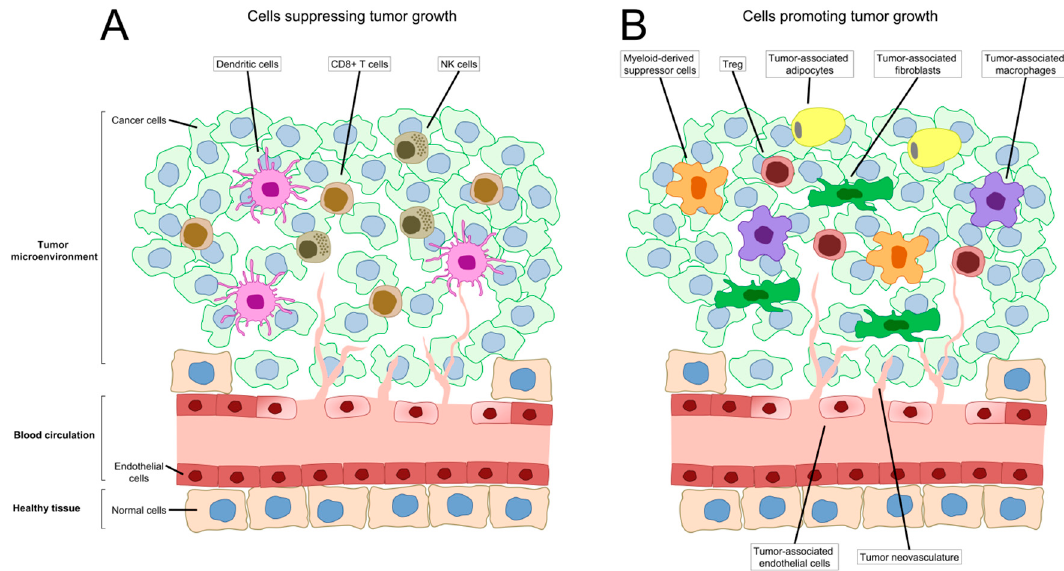
Figure 1. Cells in the tumour microenvironment that modulate tumour growth. ( A ) Cells suppressing tumour growth include dendritic cells responsible for acquisition of antigens from dying tumour cells and cross-presentation; cytotoxic CD8 + T lymphocytes that recognise cancer cells with the tumour-associated antigens and eliminate them; and NK cells that alternatively detect cancer cells deficient in MHC I, presenting stress signatures or are opsonised and, likewise, deplete them. ( B ) Cells promoting tumour growth include tumour-associated endothelial cells and the corresponding tumour neovasculature; tumour-associated fibroblasts and tumour-associated adipocytes that mainly remodel the tumour’s extracellular matrix; and T regs , tumour-associated macrophages and myeloid-derived suppressor cells all involved in various mechanisms of immune suppression.